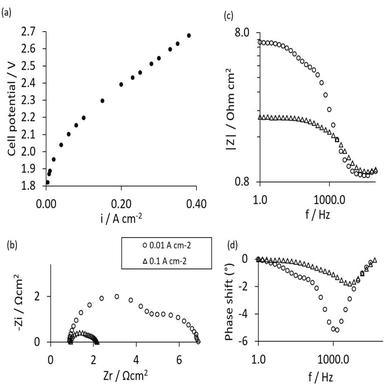
A) Polarization curve of a laboratory scale alkaline electrolyzer with 6 M KOH at room temperature; b) Nyquist plots for 0.01 and 0.1 A cm− 2 ; c) and d) Bode plots showing the dependence of absolute impedance and phase shift on the frequency for 0.01 and 0.1 A cm− 2 . Description of the laboratory scale alkaline electrolyzer can be found in.